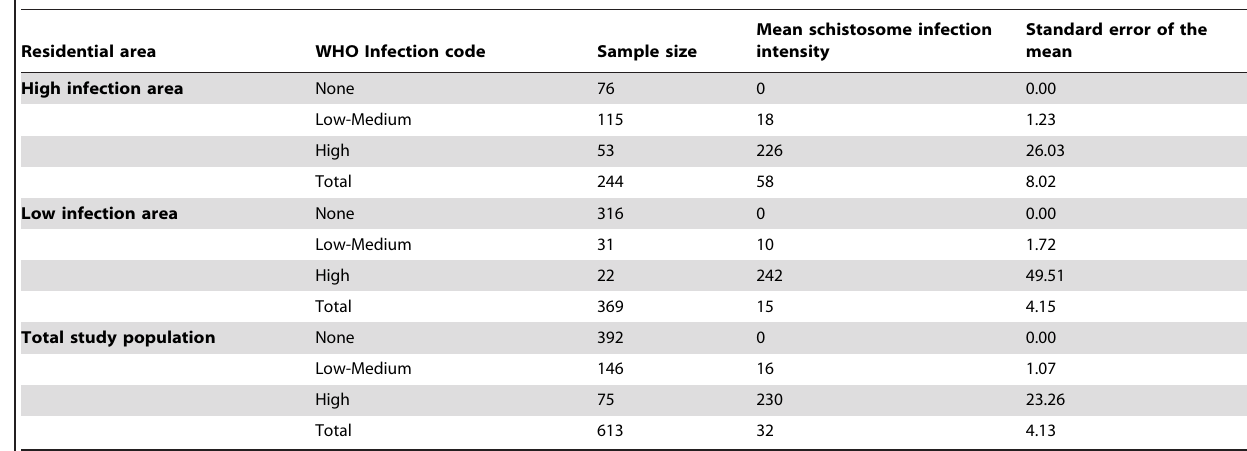
Table 1. Description of study populations’ infection levels.